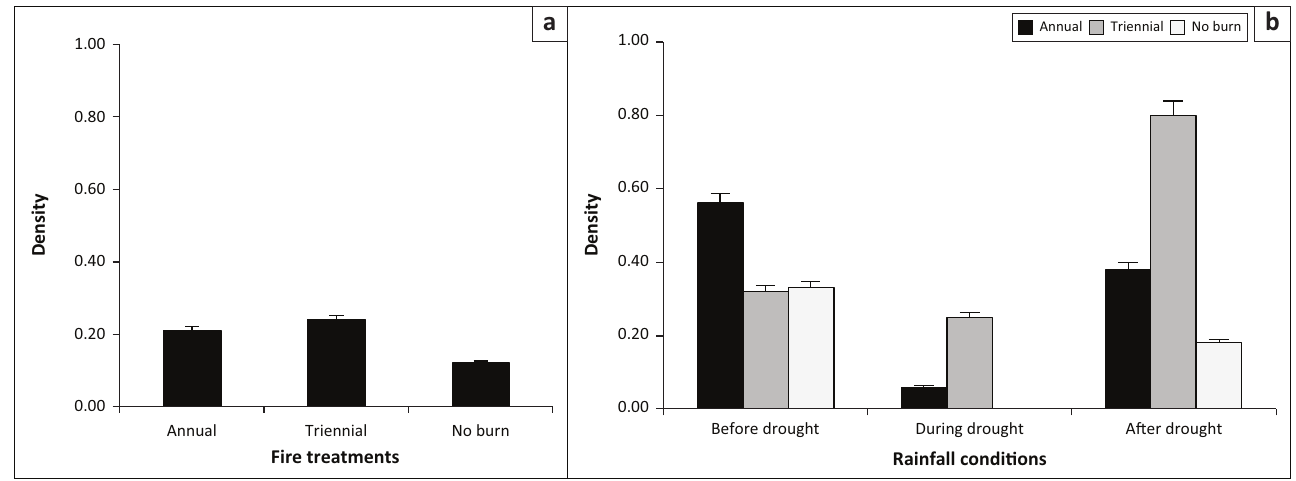
FIGURE 1: Pooled herbivore density estimates (a) for three fire treatments (annual burn, triennial burn and no-burn plots) on the Satara experimental burn plots. (b) Herbivores mean density estimate shown across rainfall conditions (before, during and after drought) and fire treatments (95 % confidence interval shown).